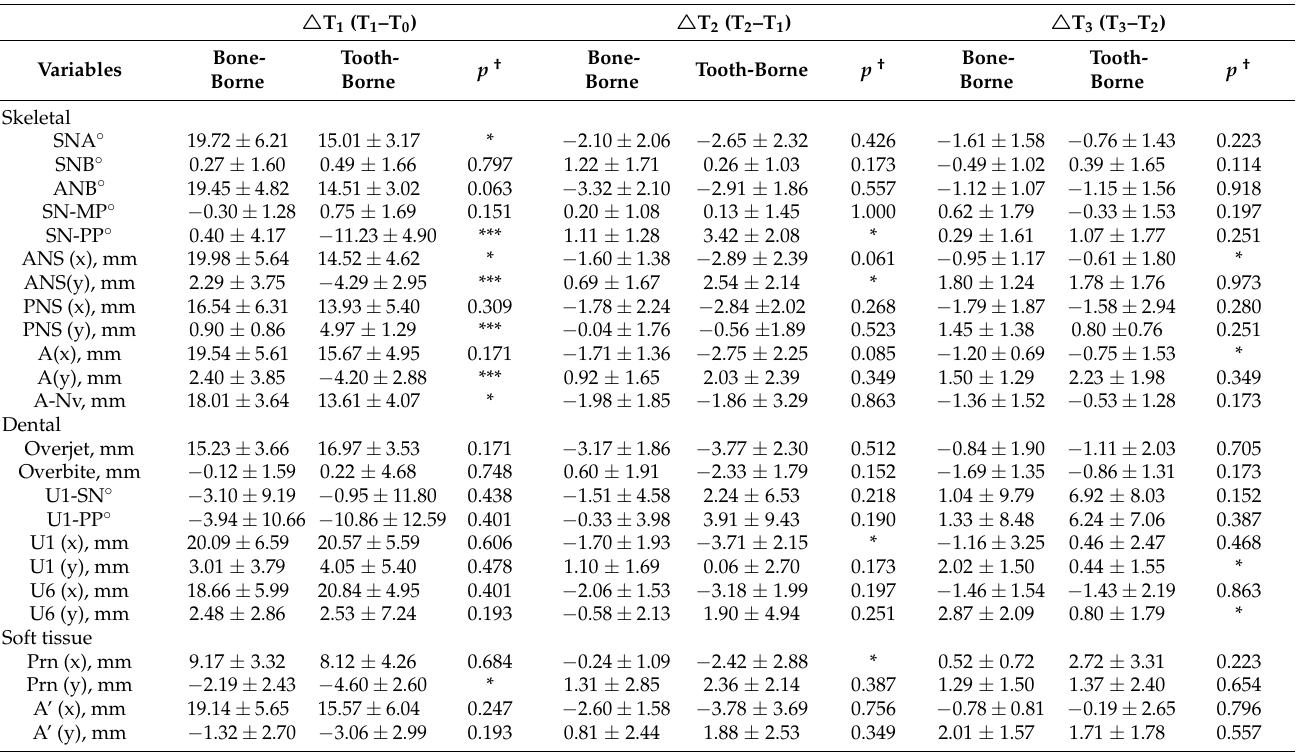
Table 6. The comparison of mean changes regarding skeletal, dental, and soft tissue components between the bone-borne RED and the traditional tooth-borne RED